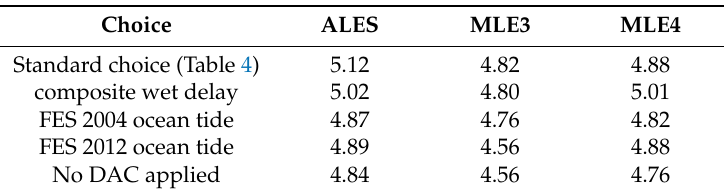
Table 8. Residual SLA, standard deviation w.r.t. tide gauge-based sea level (cm), for case 1, after 3-month smoothing, with different geophysical corrections choices.